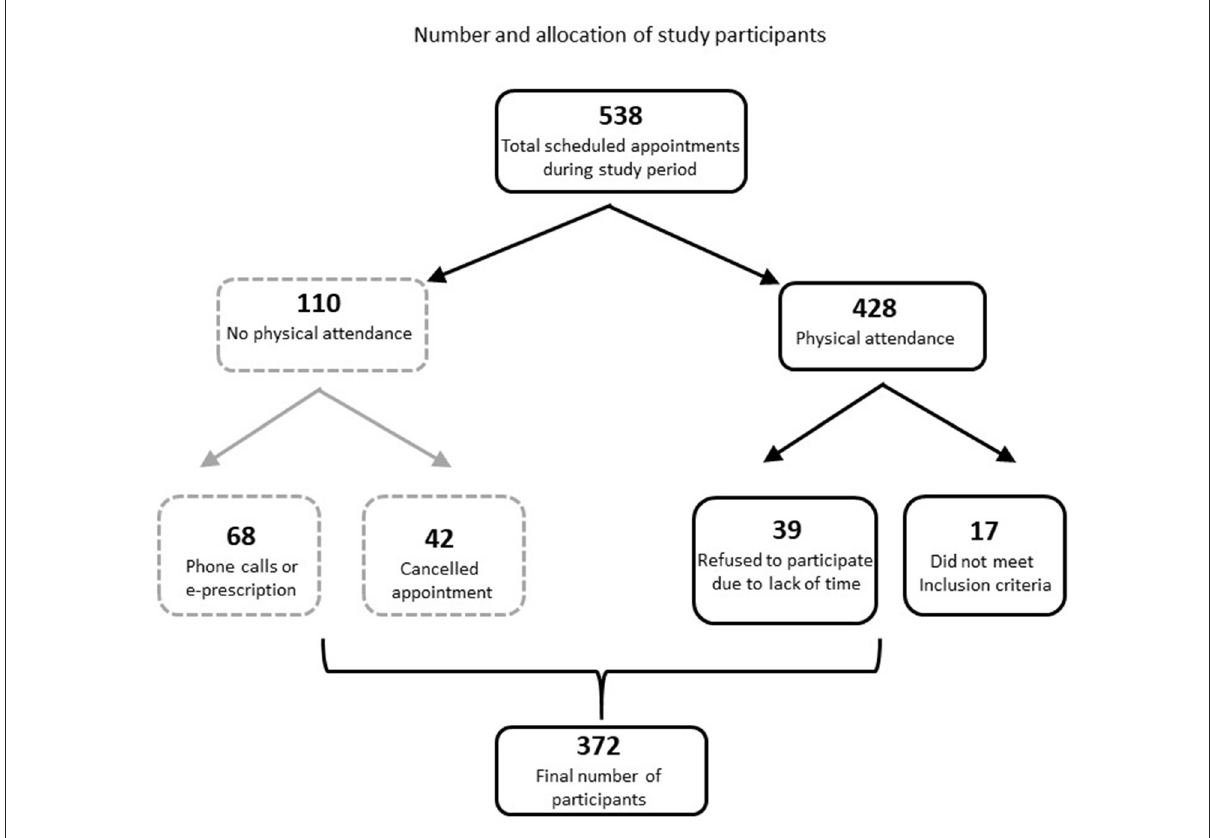
FIGURE1 An initial number of 538 appointments had been arranged during the study period. The reasons and numbers of patients of the missing appointments are shown within the dot-line square while the ones for declining participation are shown within the solid-line squares.